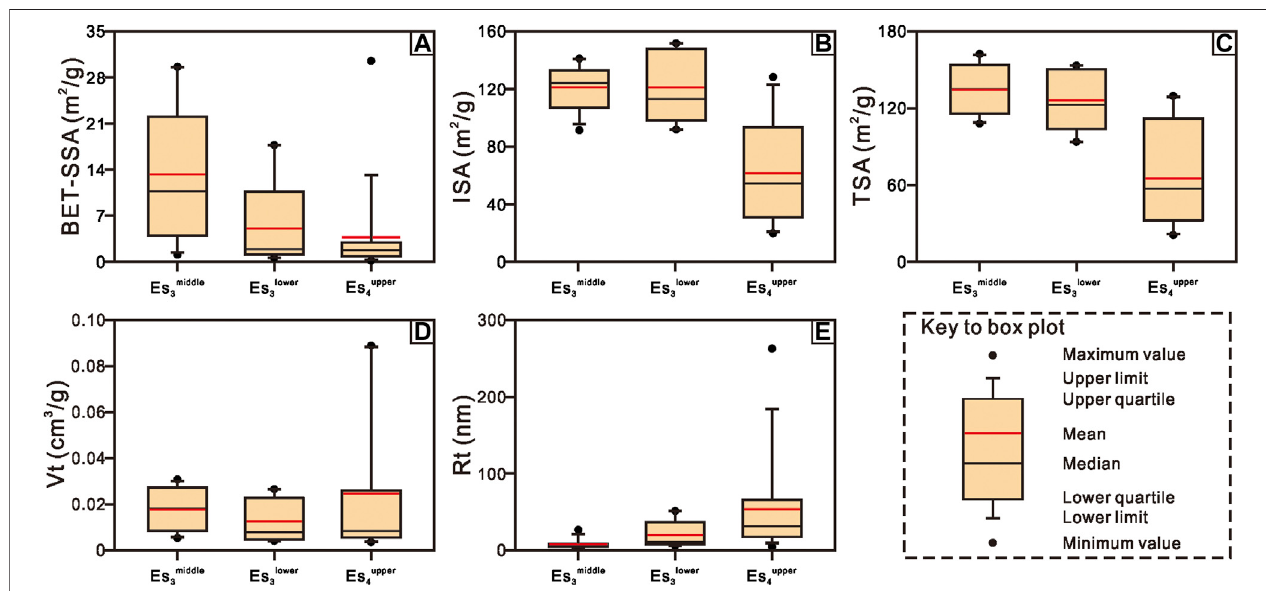
FIGURE 3 | Box plot of the outer surface area [BET-SSA, (A) ], inner surface area [ISA, (B) ], total surface area [TSA, (C) ], total pore volume [Vt, (D) ], and calculated average pore diameter [Rt (cid:2) 4 × Vt/(BET-SSA), (E) ] of the shales from different sections.